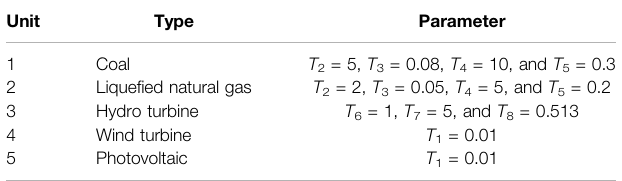
TABLE 2 | Parameters of transfer functions.